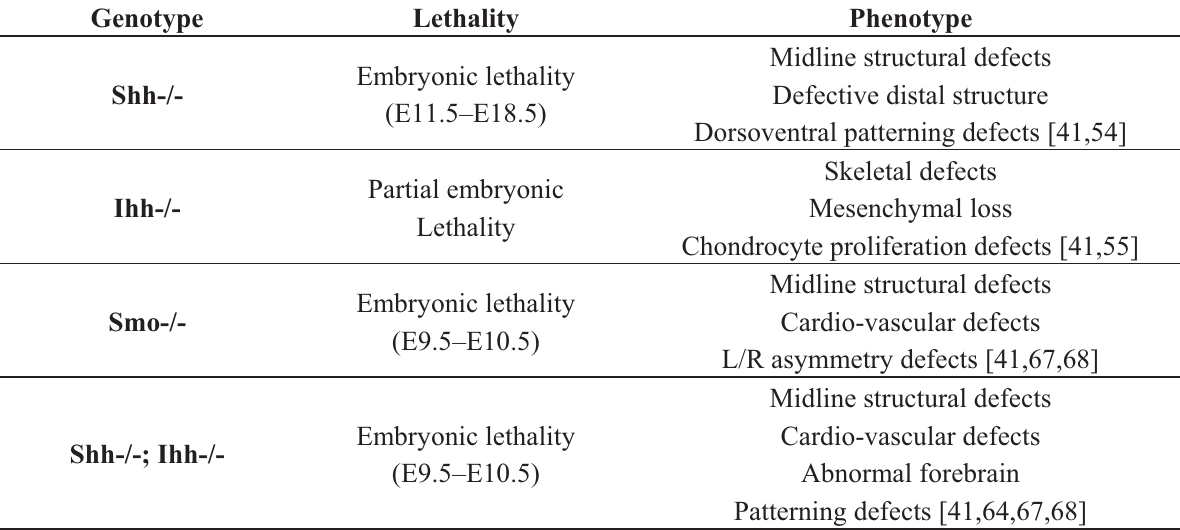
Table 2. Genetic models and HH signaling during